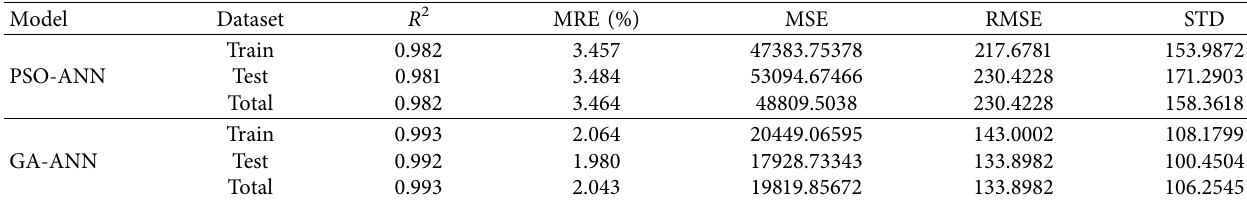
Figure 3: Relative deviation analysis to determine the accuracy of (a) PSO-ANN and (b) GA-ANN models in predicting the target parameter. The ARD, RMSE, MSE, STF, and R 2 were used to evaluate the models. Table 1: Statistical parameters calculated for the proposed